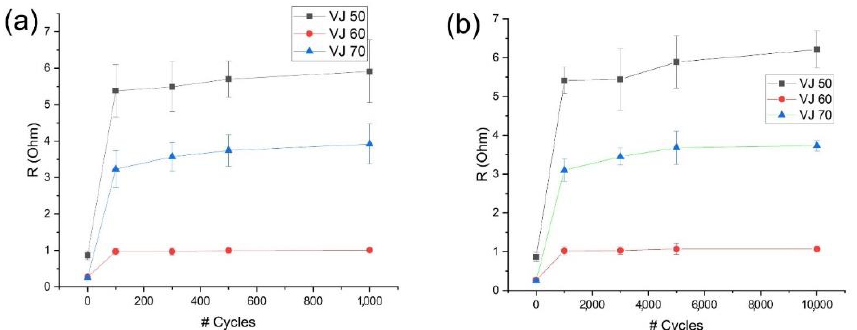
Figure 3. Dependence of the electrical resistance of resistors chain on ( a ) number of stretching and ( b ) bending cycles.